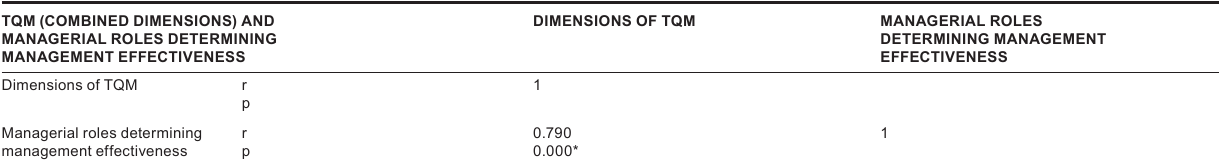
Table 6 Correlation: TQM (combined dimensions) and managerial roles determining management effectiveness (combined dimensions) (N = 198)